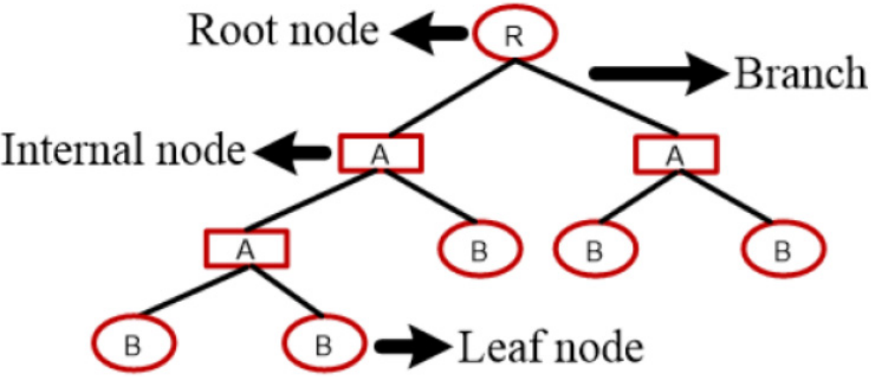
Figure 2. Construction of the decision tree.